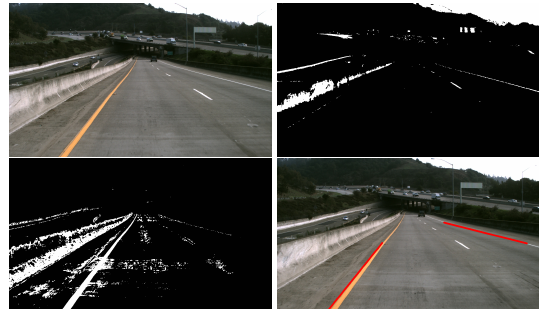
Figure 3. The original image (up-left) is masked by white and yellow colors (up-right and down-left), the Hough transformation is applied to binary images and the left and right road boundaries are modeled by two lines (down-right).